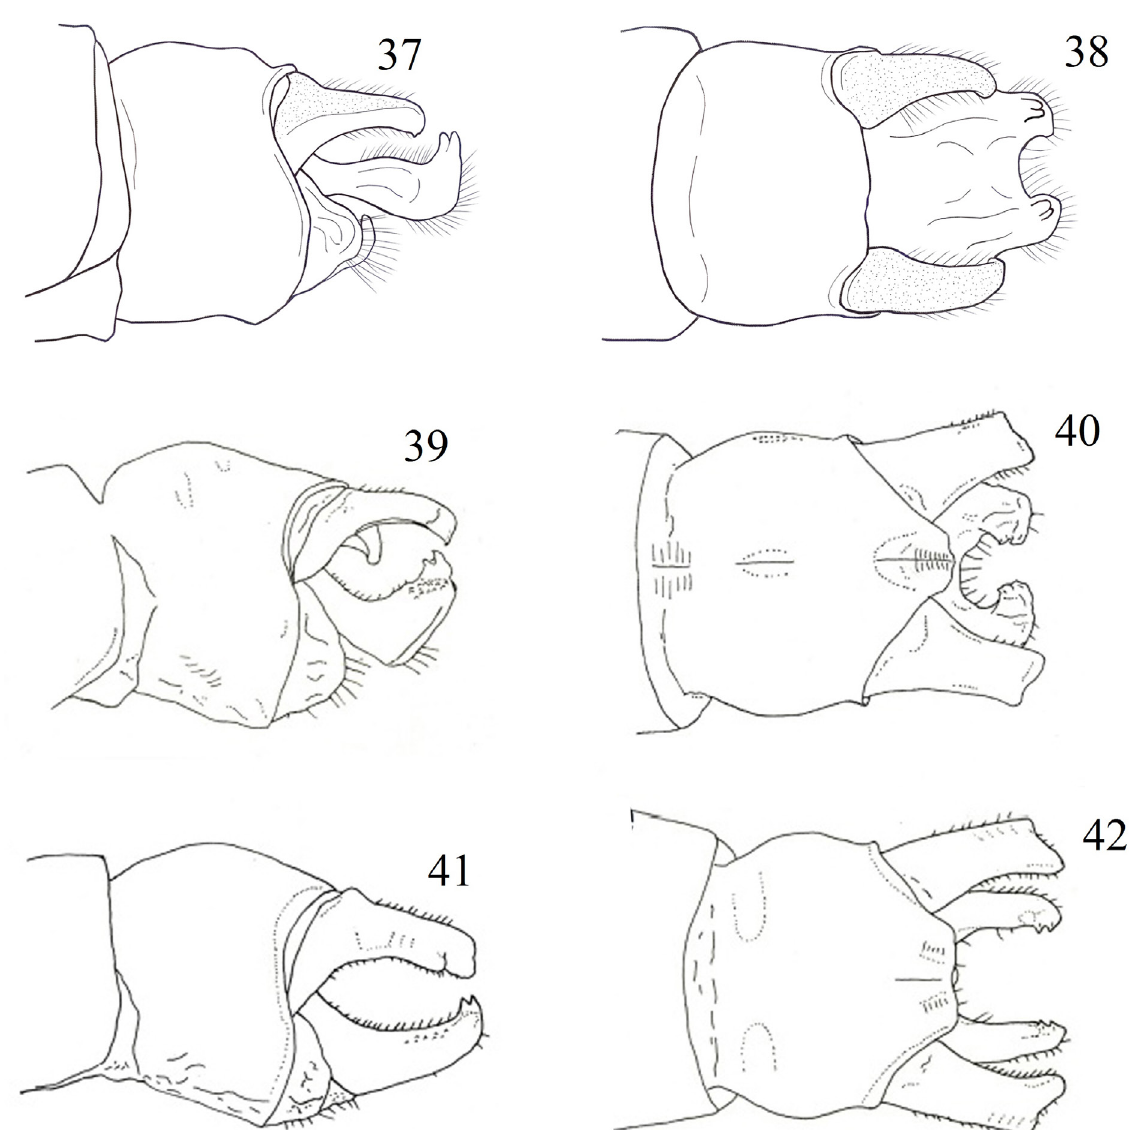
Figs 37–42. Anal appendages of species of Chlorogomphus Selys, 1854, ♂♂ . 37–38 . C. vani sp. nov., holotype ( ZCDTU 2021042001-ODO). 39–40 . C. auratus Martin, 1910 (rearranged from Kompier